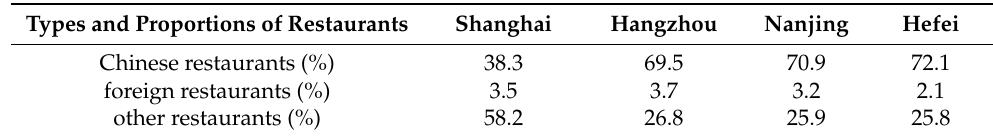
Table 1. Proportion of Chinese restaurants and foreign restaurants in the main urban areas of the four central cities in the YRD.